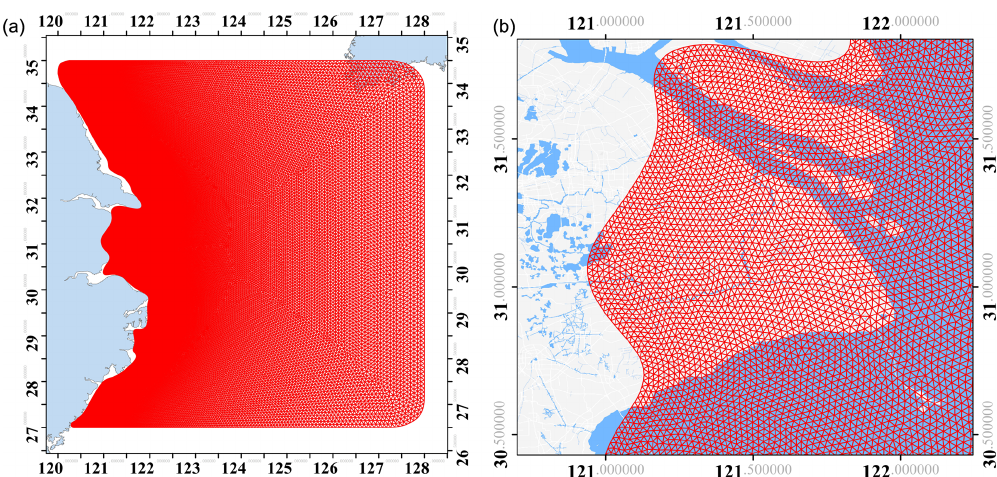
Figure 3. Shanghai Coastal Storm Surge Model with the resolution varying from 10 to 100km. Panel (a) shows the unstructured mesh with the differing resolution, ranging from 10 to 100km. Panel (b) provides an enlarged image of the mesh around Shanghai. Sources: Esri, DeLorme, HERE, USGS, Intermap, iPC, NRCAN, Esri Japan, METI, Esri China (Hong Kong), Esri (Thailand), MapmyIndia and